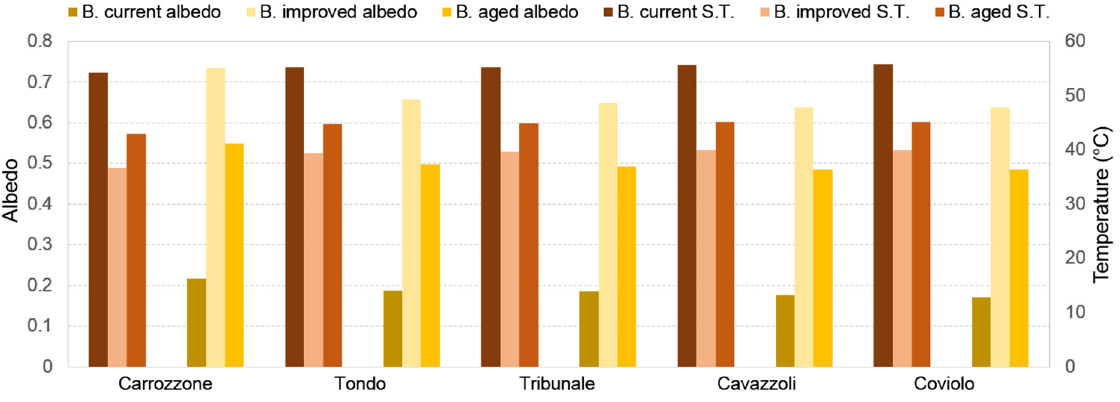
Figure 10. Mean albedo and temperature values for building roofs in the three scenarios: current, improved, and aged.